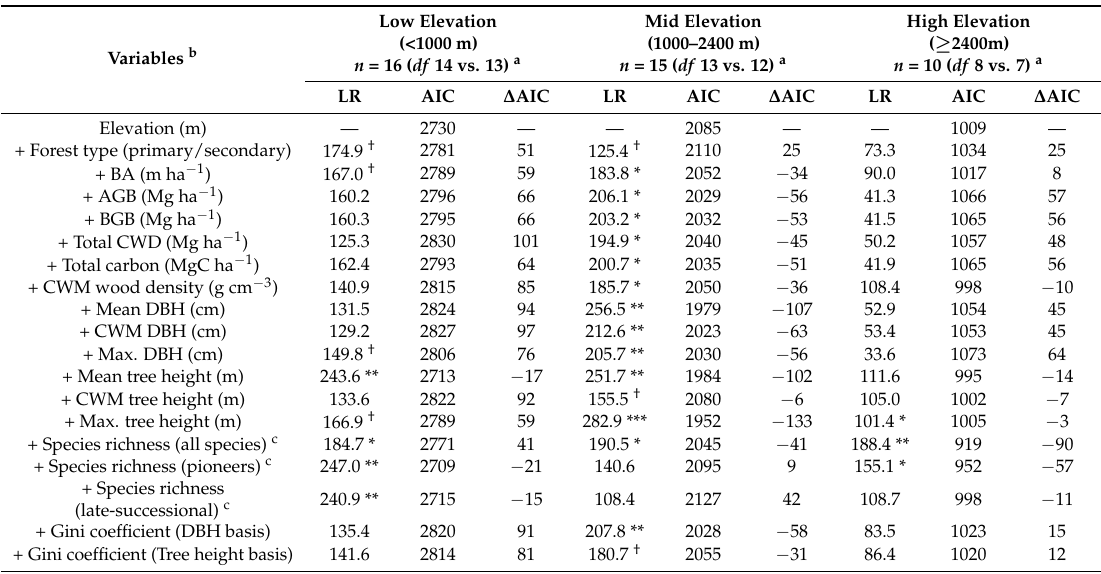
Table 4. Summary of model comparisons between elevation effect alone and elevation effect plus one of forest characteristics effects at three elevation